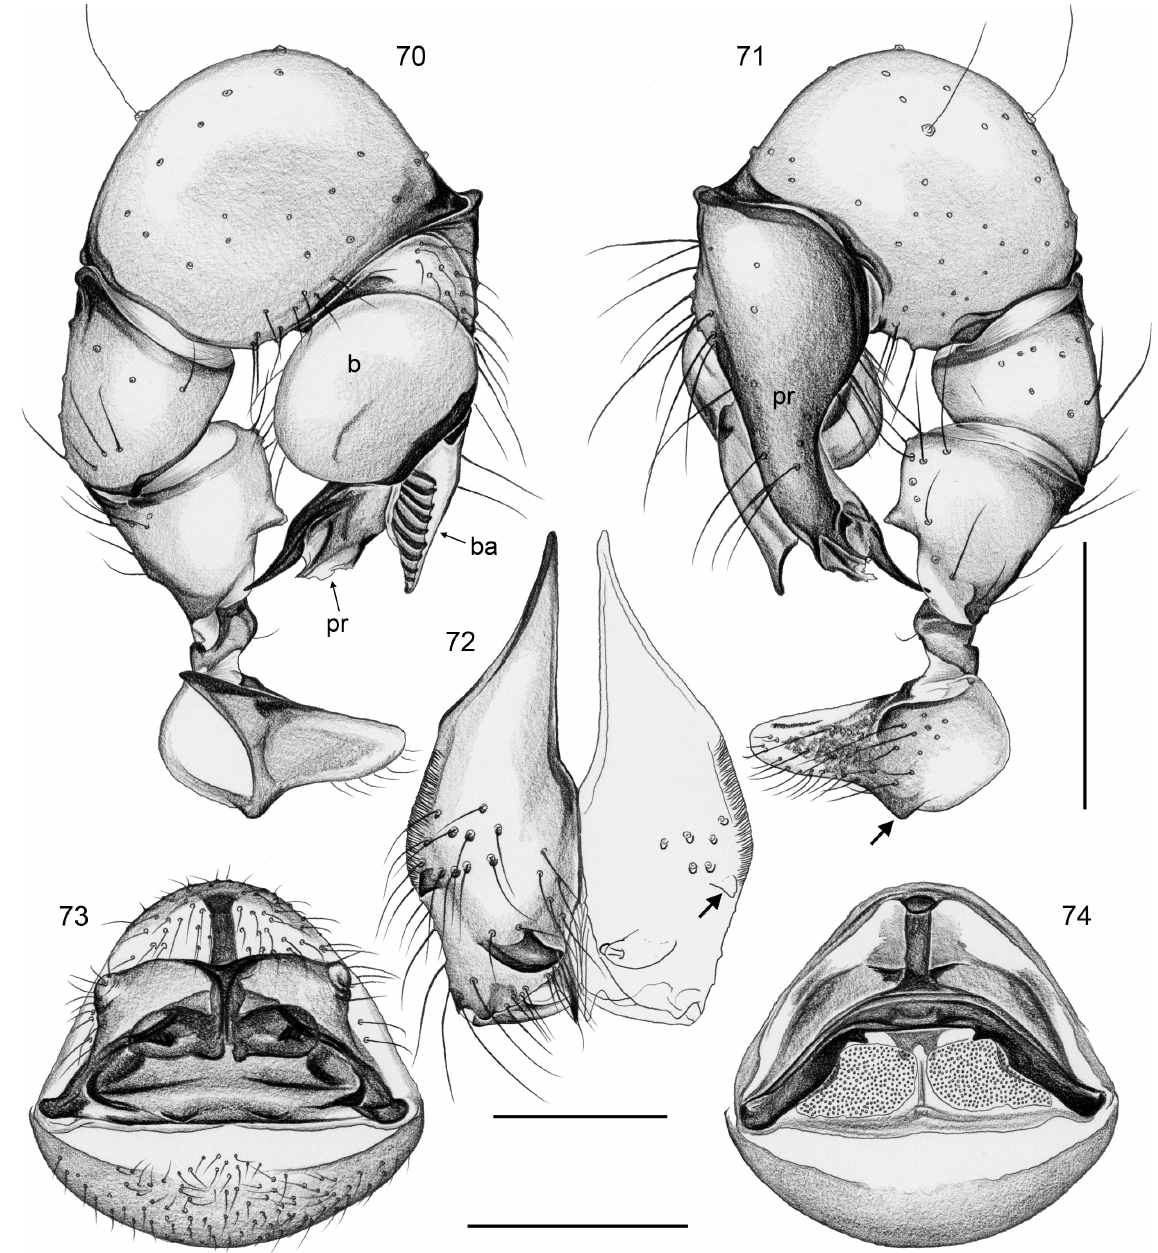
Figs 70-74. Crossopriza johncloudsleyi Deeleman-Reinhold & van Harten, 2001. 70-71. Left ♂ palp, prolateral and retrolateral views (arrow points to distinctive joint on coxa). 72. ♂ chelicerae, frontal view. 73-74. ♀ genitalia, ventral and cleared dorsal views. b: genital bulb; ba: bulbal apophysis; pr: procursus. Scale lines: 0.2 mm (72), 0.5 mm (70-71,